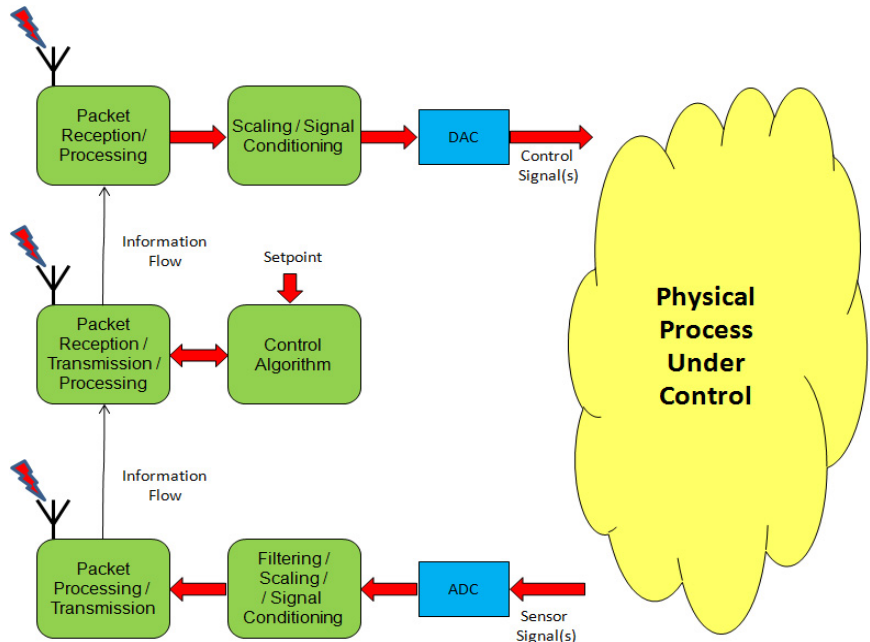
Figure 1. Wireless sensor/actuator network (WSAN)-based Control